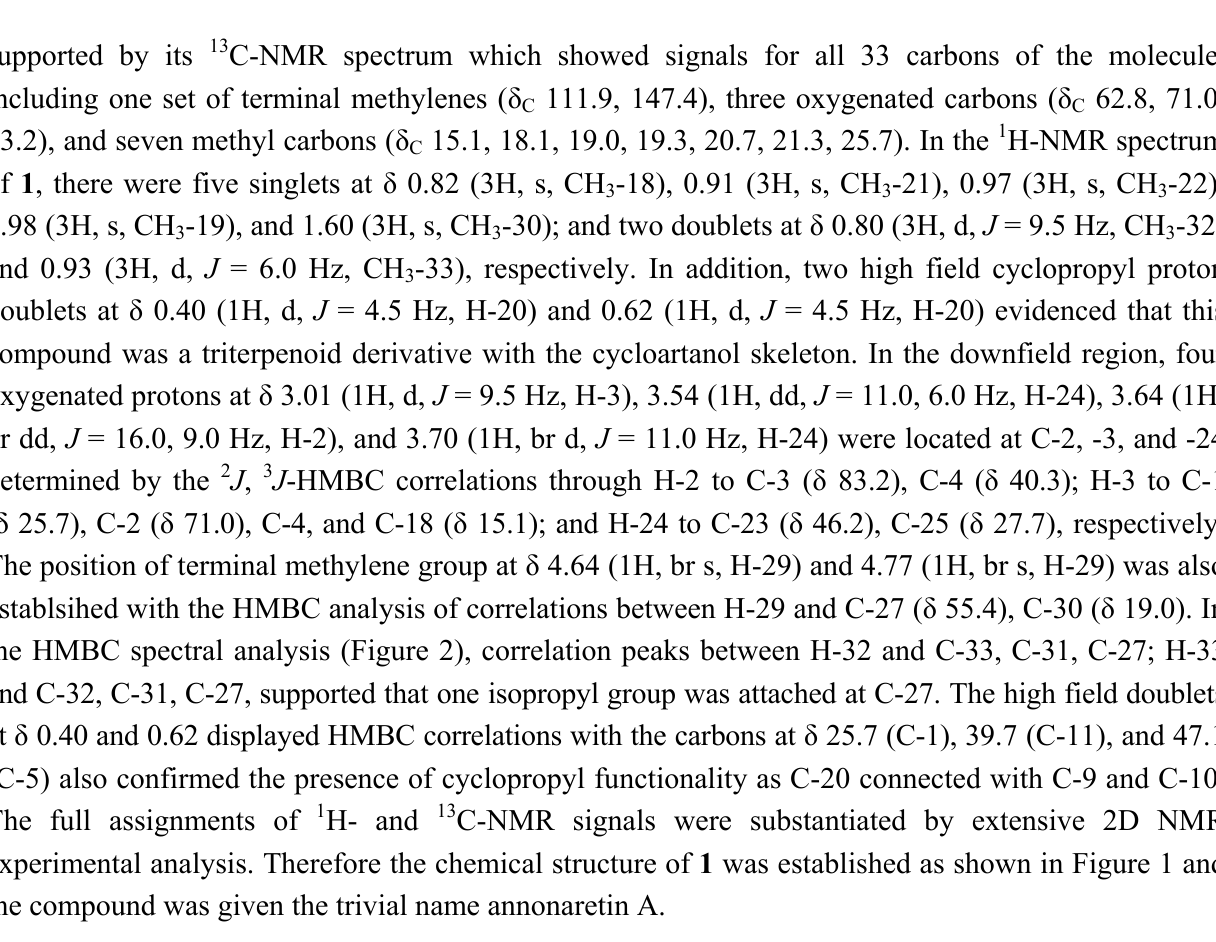
Figure 1. Structure and significant HMBC ( → ) correlations of compound 1